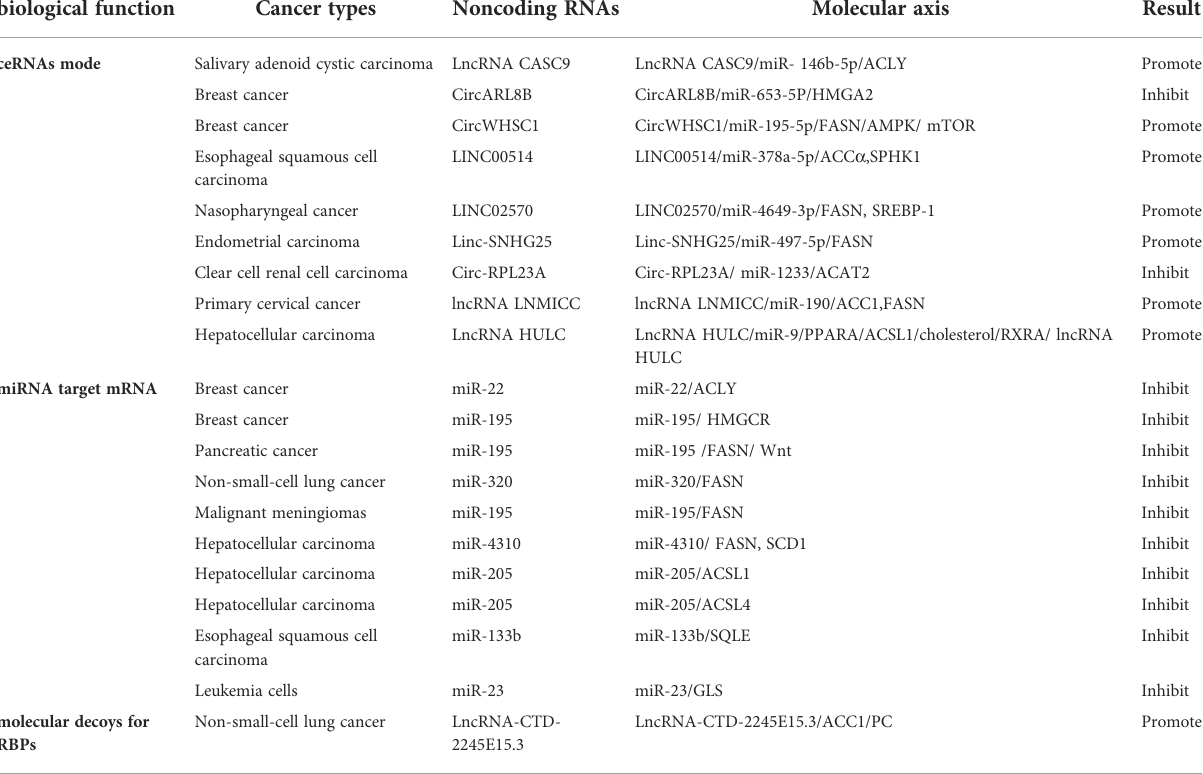
TABLE 1 Noncoding RNAs affect tumor lipid metabolism through different